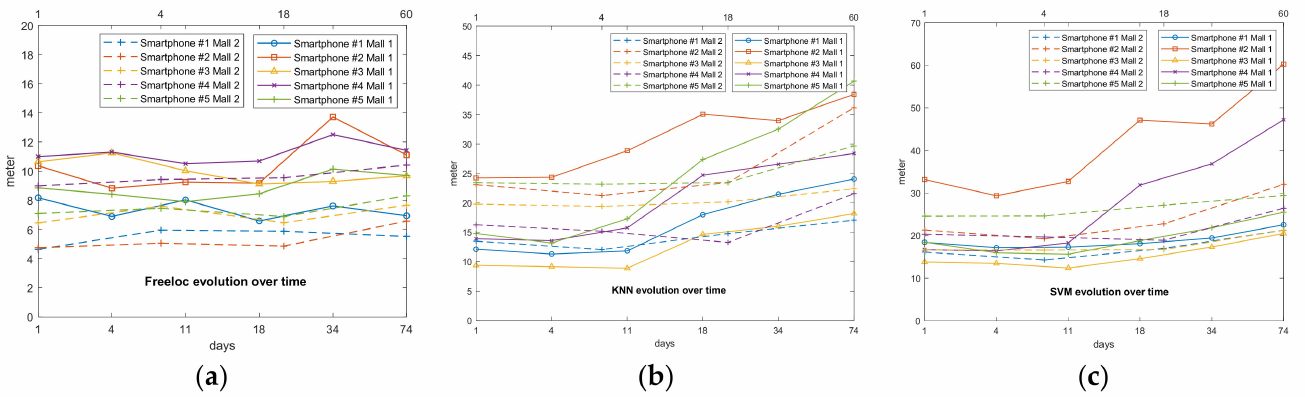
Figure 6. Evolution of the mean error over the time for each of the smartphones in both malls with ( a ) Freeloc, ( b ) KNN, and ( c )